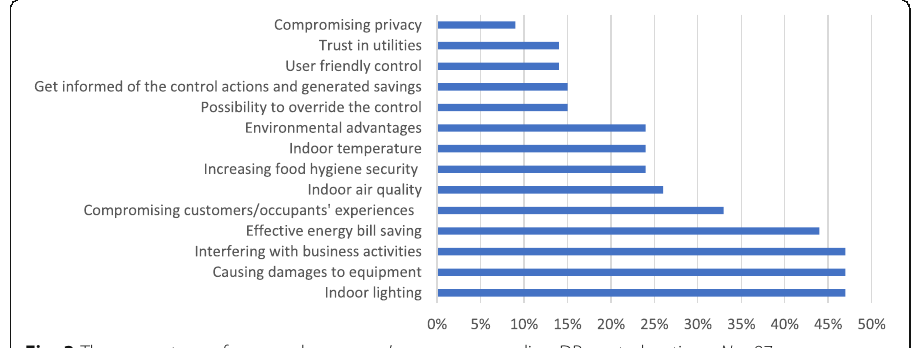
Fig. 3 The percentage of surveyed managers ’ concerns regarding DR control options. N =